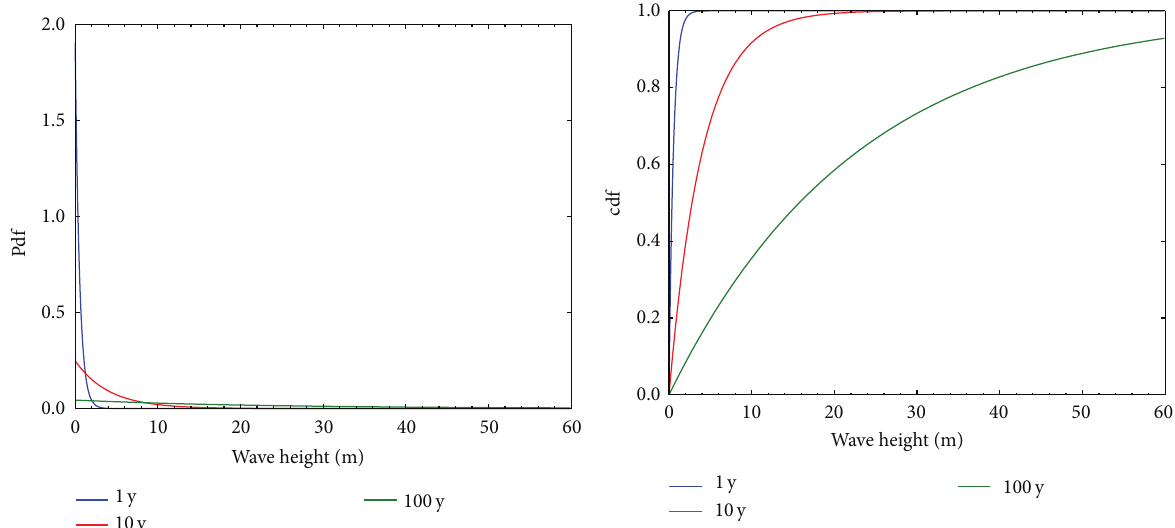
Figure 15: pdf and cdf of wave height ℎ for three different values of return periods (1, 10, and 100 years).